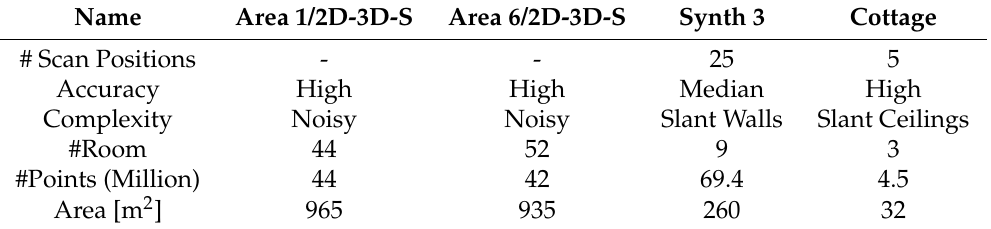
Table 2. Specifications of the test datasets.